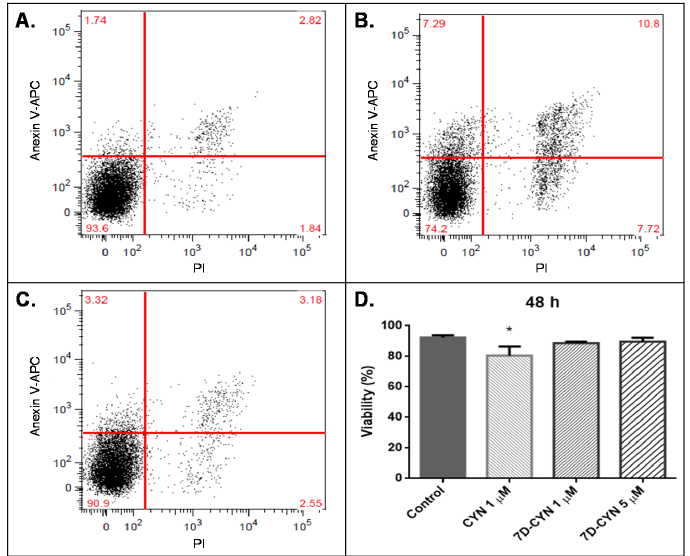
Figure 6. Biological activity of CYN and 7D-CYN purified from C. raciborskii 11K on HepG2 cells